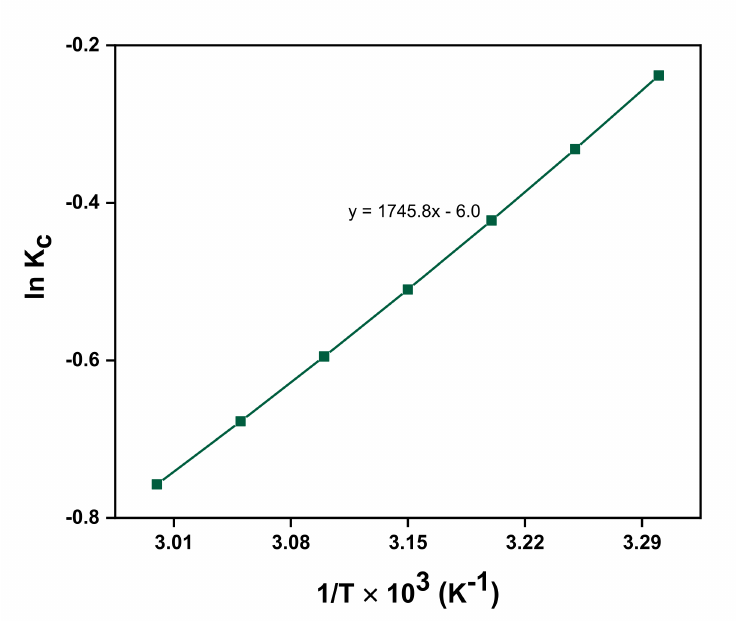
Figure 13. Plot between ln K c and 1/T